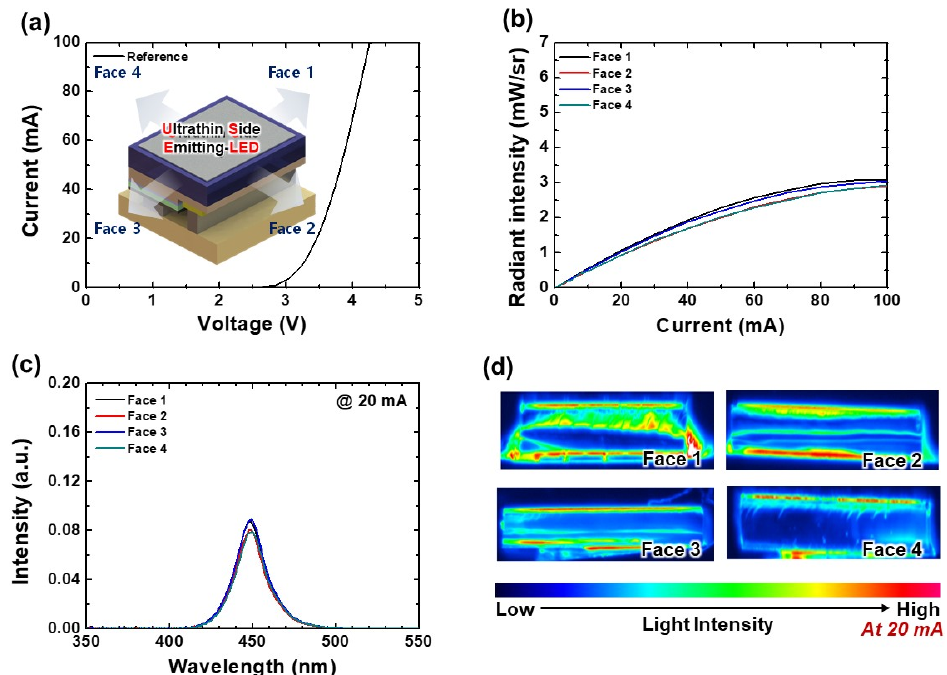
Figure 2. ( a ) I-V characteristics of a USE-LED (Reference sample). Inset shows the schematic diagram for light emitting from its 4 Faces. ( b ) LOP characteristics, ( c ) EL spectra at 20 mA, and ( d ) light intensity distribution over each Face (or, sidewall) of a USE-LED.